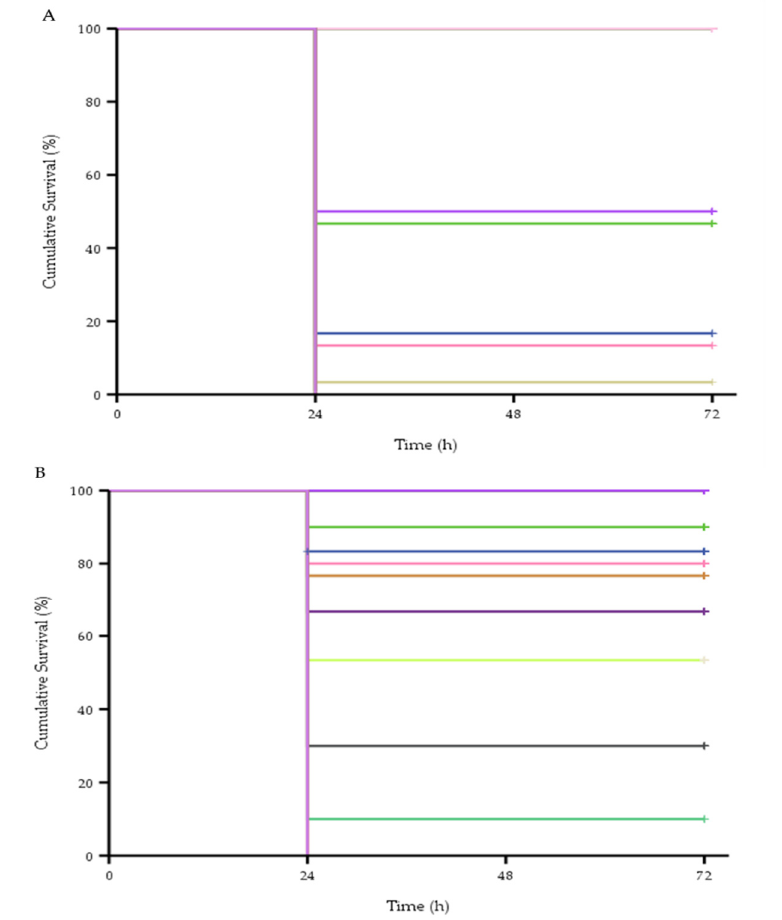
Figure 6. The cumulative survival percentage of whiteleg shrimp after anesthesia of STD-CO ( A ) and CO-NLC ( B ). Kaplan–Meier survivorship curves over time (h) for whiteleg shrimp was constructed and performed the log-rank (Mantel-Cox) statistical test to compare the groups.